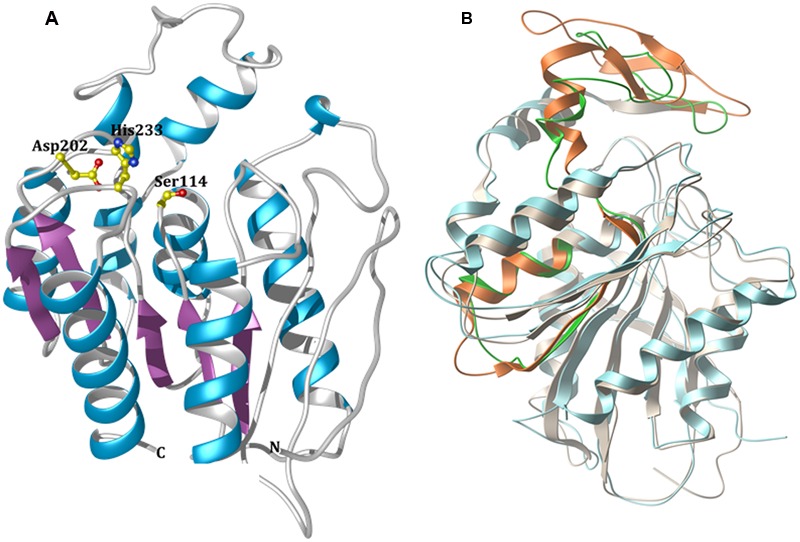
Modeled 3D structure of EstDZ3. (A) The modeled 3D structure of EstDZ3. Residues Ser114, Asp202, and His233, which are predicted to form the catalytic triad, are indicated in ball-and-stick representation. The figure was prepared using Chimera (Pettersen et al., 2004). (B) Superposition of the predicted EstDZ3 structure (shown in cyan) with that of its closest structural homolog, the cinnamoyl esterase Lj0536 (PDB code: 3PF8, shown in gray). The “insertion subdomain” of Lj0536 is depicted in orange, while the corresponding region in EstDZ3 is indicated in green. The figure was prepared using MolSoft (MolSoft LLC, 2000).